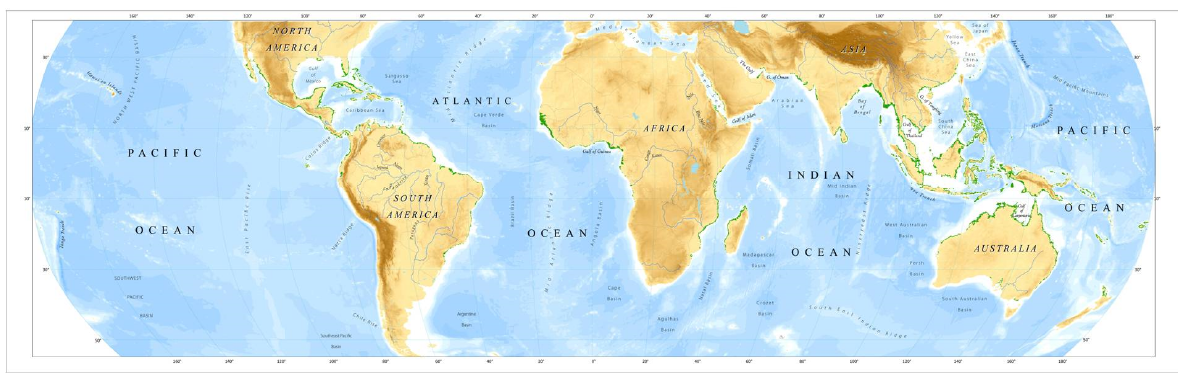
Figure 1. Distribution of the mangrove forests (green) of the world for the year 2000 at 30 m spatial resolution [1]. High quality contributions emphasizing (but not limited to) the topic areas listed be- low were solicited for the special issue: